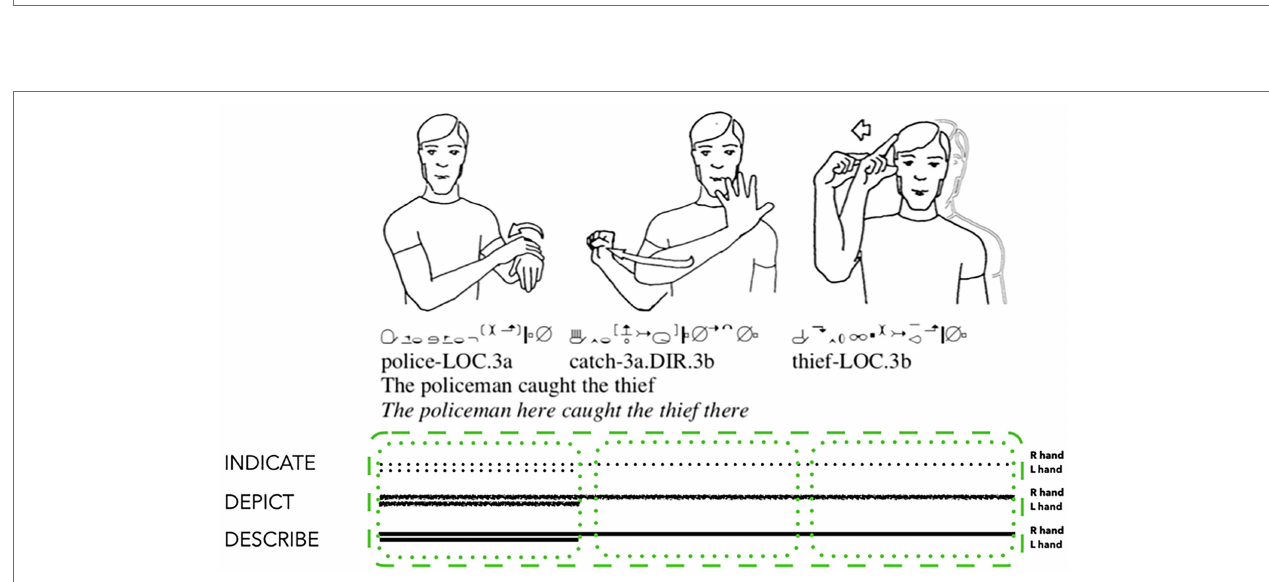
FIGURE 6 | Composite utterance produced by a deaf signer of Norwegian Sign Language (adapted from Ferrara and Halvorsen, 2017: 285 and reproduced with permission from the authors and John Benjamins Publishing Company, Amsterdam/Philadelphia, https://benjamins.com/catalog/gest). This example can be accessed online: Ferrara and Halvorsen, 2021; RPH12_PS_Frosk3.mp4;